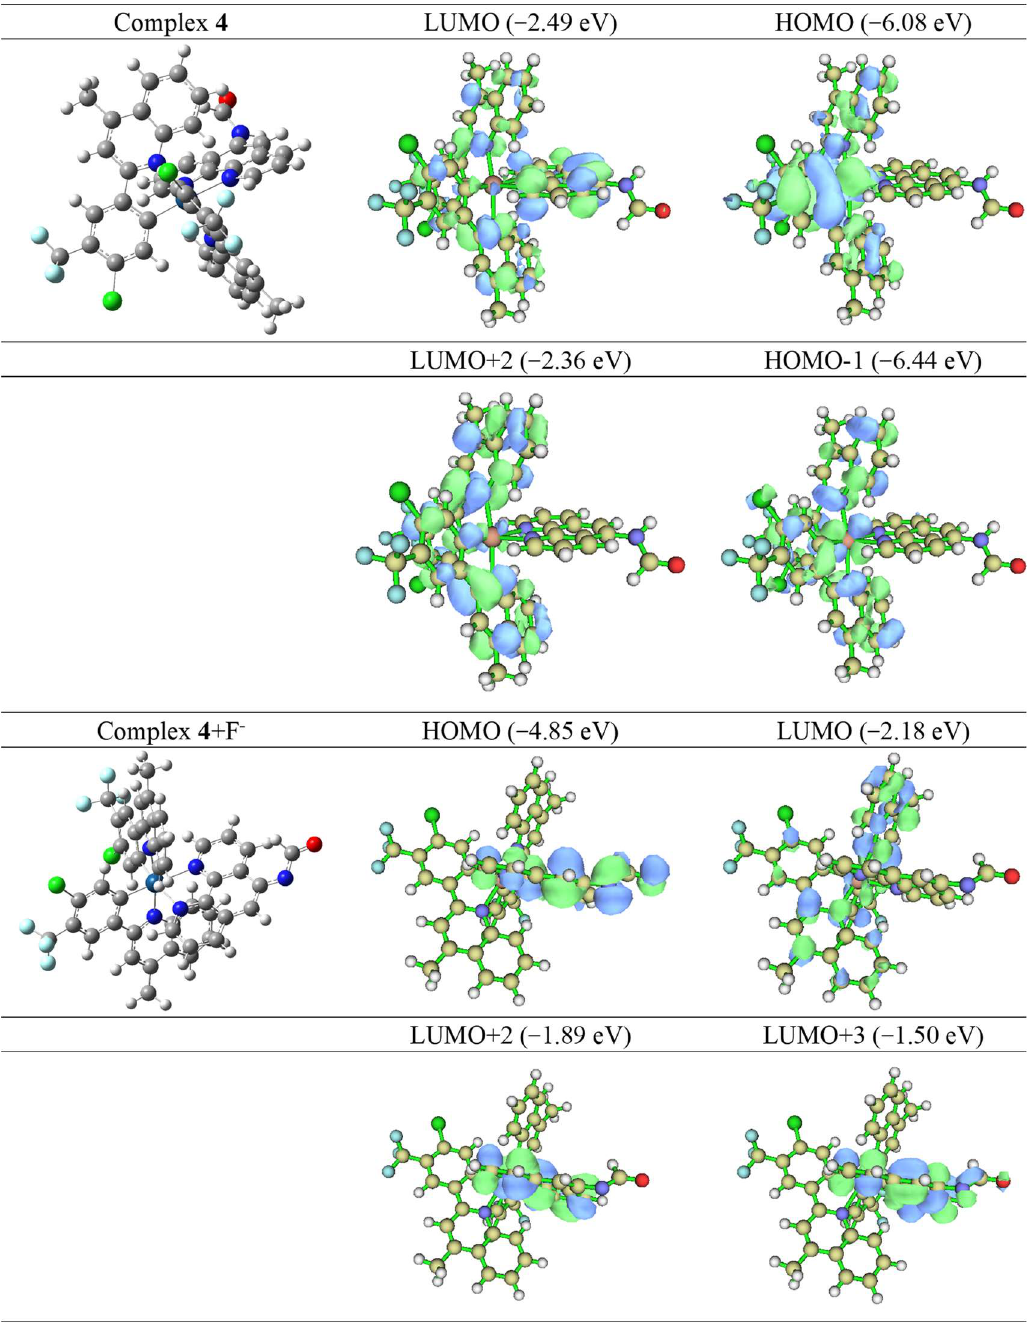
Figure 5. The distributions of molecular orbitals of 4 and 4 + F − .